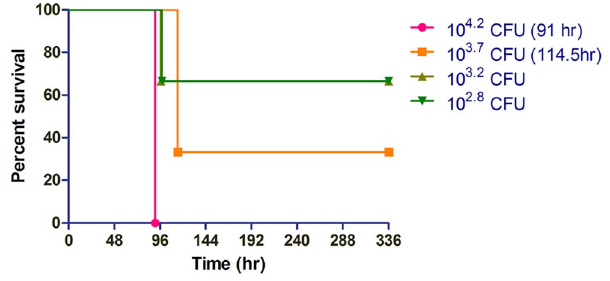
Fig. 4. Male host response to lung-specific delivery of B. pseudomallei . Groups of 3 male albino C57BL/6J mice were challenged with increasing doses of luminescent B. pseudomallei strain JW280 by IMIT infection. Mice were monitored for 14 days (336 hr) for disease progression and euthanized at the onset of moribund disease presentation. Survival curves are used to present the dose-dependent response of the host to increasing bacterial challenges. The MTTD was calculated for groups with $ 50% mortality, as indicated.